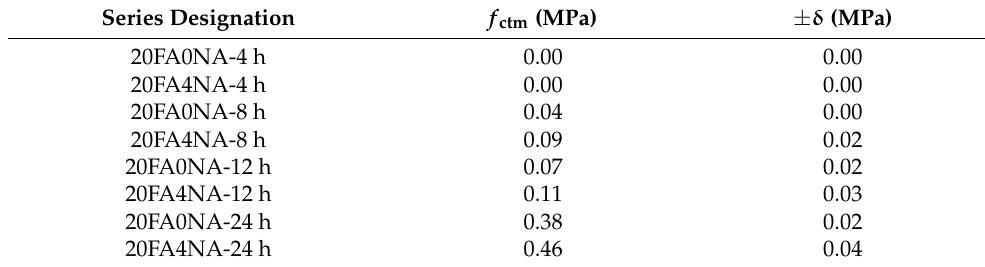
Table 8. Tensile strength test result— f ctm